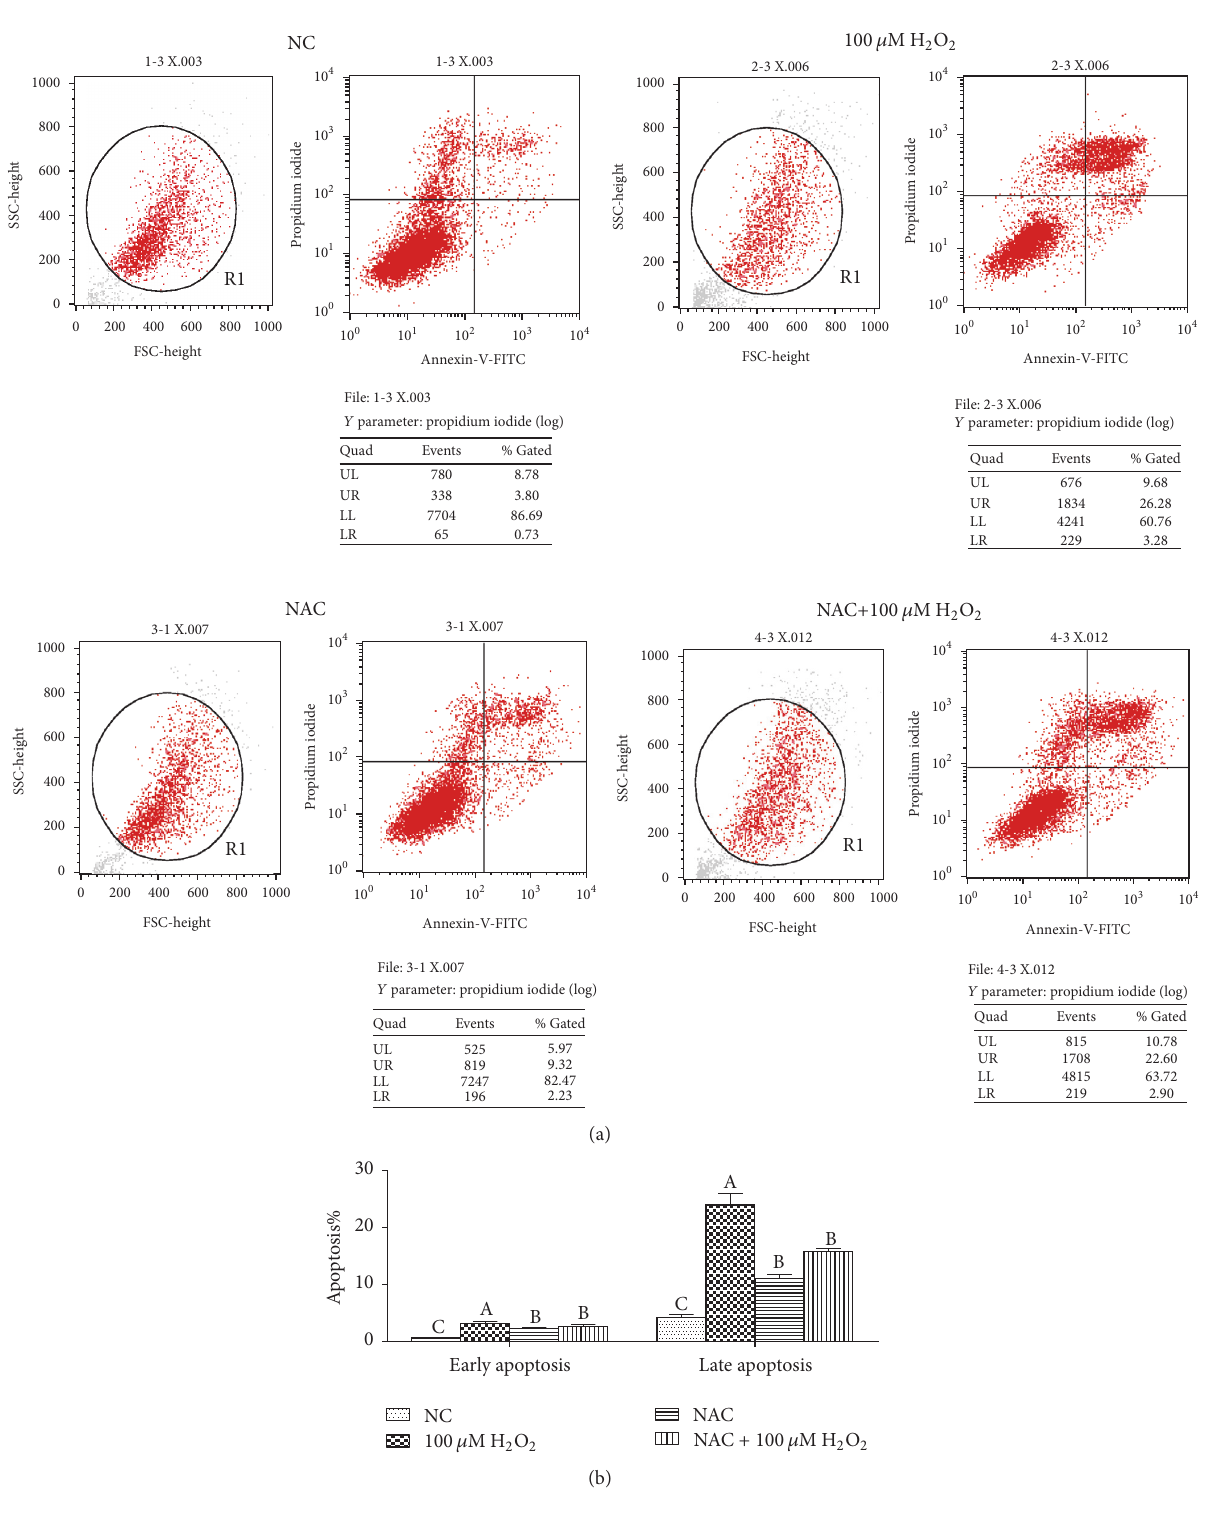
Figure 6: Cell apoptosis in the IPEC-J2 cells. (a) Representative flow cytometry diagrams and (b) apoptosis rate. Cells were treated with 0 (NC) or 800 𝜇 M NAC and 0 or 100 𝜇 M H 2 O 2 , respectively. Data were expressed as means ± SEM of at least three independent experiments. a–c Values with different letters are significantly different ( 𝑃 < 0.05